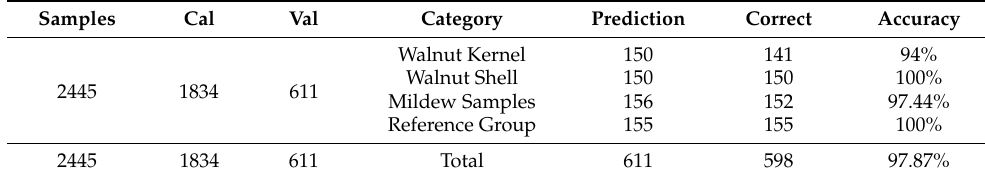
Table 3. Classification results of KNN discriminant model.